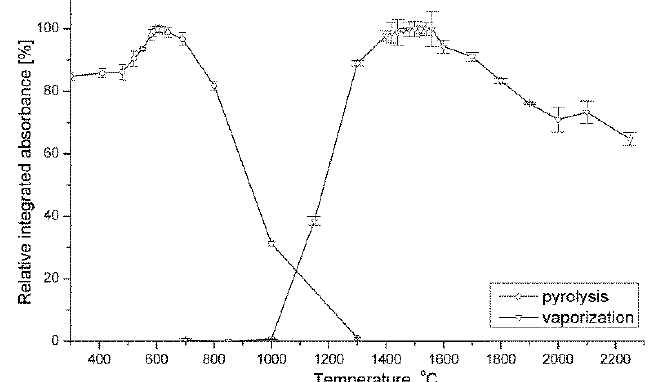
Figure 1. Dependence of GaF molecule relative absorbance at 211.248 nm on vaporization tempera- ture ( T vapor. ) ( T pyrol. = 550 °C) and pyrolysis temperature ( T pyrol. ) ( T vapor. = 1540 °C); m (Pd) = 5.0 μ g; ture ( T vapor. ) ( T pyrol. = 550 ◦ C) and pyrolysis temperature ( T pyrol. ) ( T vapor. = 1540 ◦ C); m (Pd) = 5.0 µ g; m (Zr) = 0.1 μ g; m (Ru) = 3.0 μ g; C (Ga pretr. ) = 50 μ g; m (Ga sol. ) = 20 μ g; m (CH 3 COONa) = 5.0 μ g. m (Zr) = 0.1 µ g; m (Ru) = 3.0 µ g; C (Ga pretr. ) = 50 µ g; m (Ga sol. ) = 20 µ g; m (CH 3 COONa) = 5.0 µ